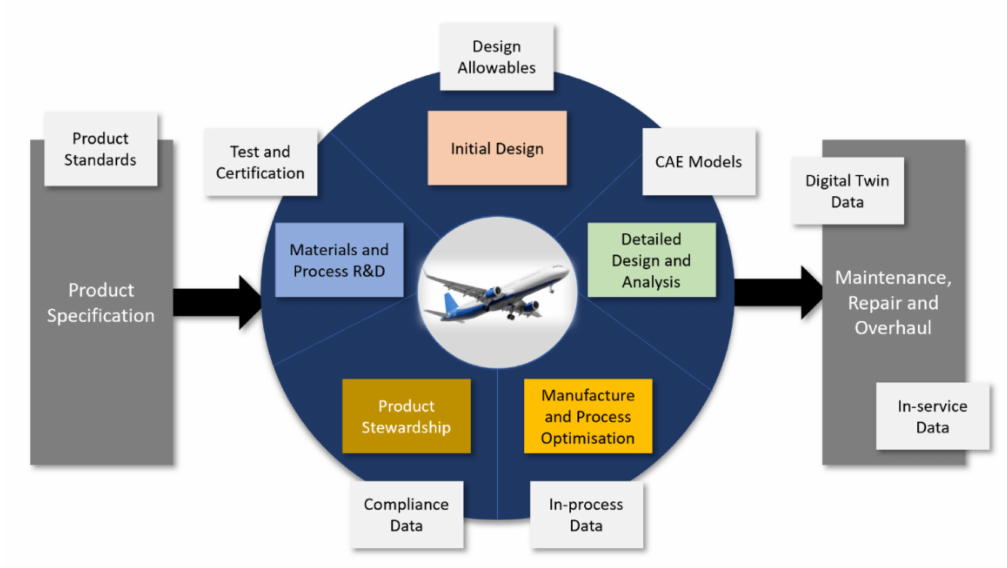
Figure 1. Plethora of data involved in aircraft development and through-life